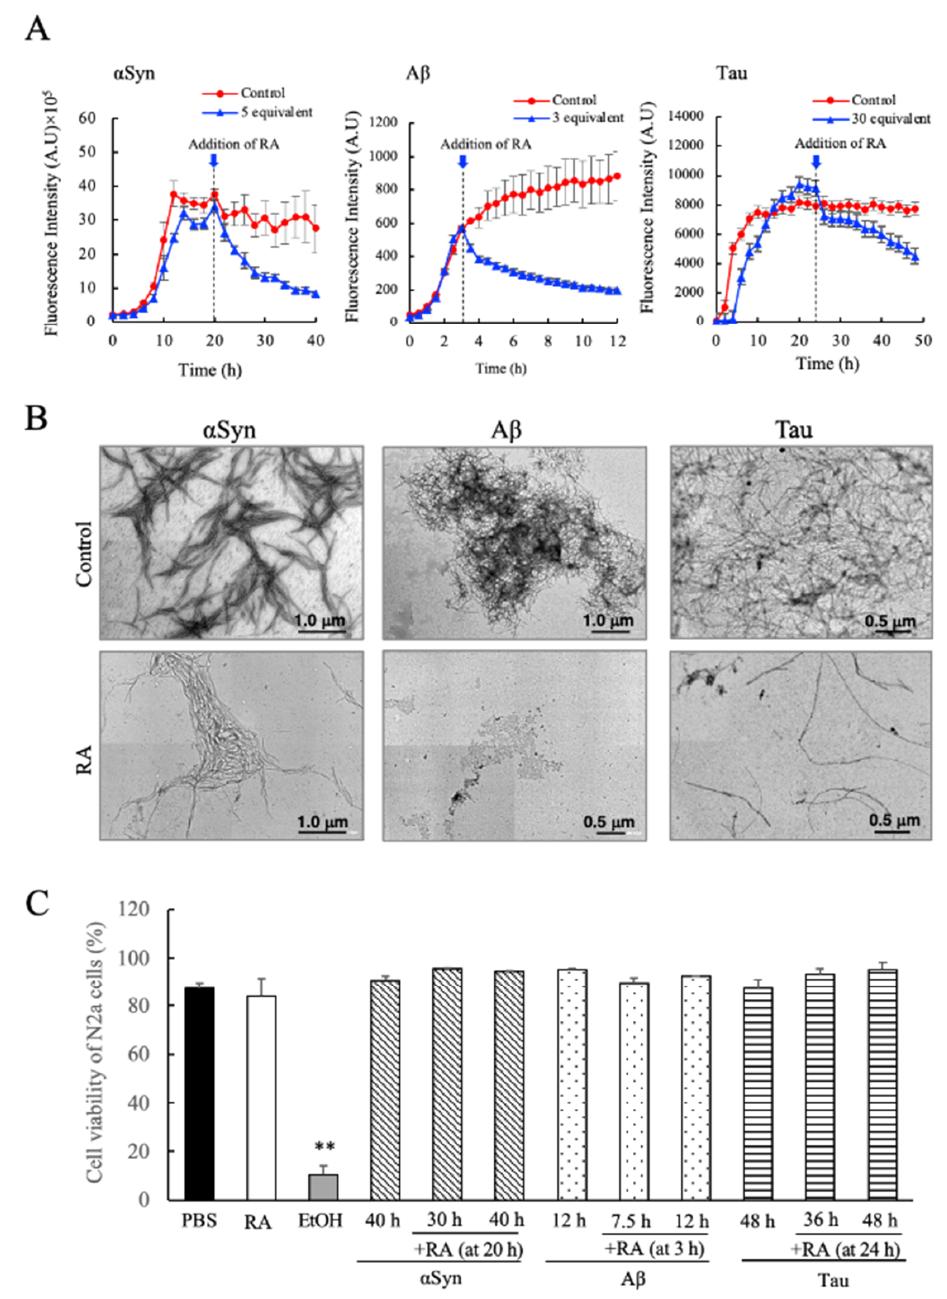
Figure 5. Evaluation of the fibril dissociative abilities of rosmarinic acid (RA) on preformed amyloid fibrils of α -synuclein ( α Syn), amyloid beta (A β ), and Tau. ( A ) RA was added to experiments where each fibrillogenic protein was allowed to form fibrils for a designated interval (20 h for α Syn, 3 h for A β , and 24 h for Tau). The specific instance that RA was added to each sample is denoted within each figure by the dotted lines and arrows. ( B ) TEM images of α Syn (at 40 h), A β (at 12 h), and Tau (at 48 h) samples after the addition of RA according to the protocol described in ( A ). ( C ) Determination of the cytotoxicity of RA-containing fibril samples, measured by Tali ™ Cytometer analysis on Neuro2a (N2a) cells. Each fibril sample (either treated or not treated with RA) was collected at the indicated times (at 30 h and 40 h for α Syn, 12 h and 7.5 h for A β , 36 h and 48 h for Tau) and assayed for cytotoxicity. Data are means ± SEM ( n = 3). PBS, phosphate bu ff ered saline; EtOH, 70% ethanol solution. There are no significant di ff erences in toxicity between RA-treated and non-treated fibril samples. ** p < 0.01 vs. the PBS groups (Tukey–Kramer multiple comparison